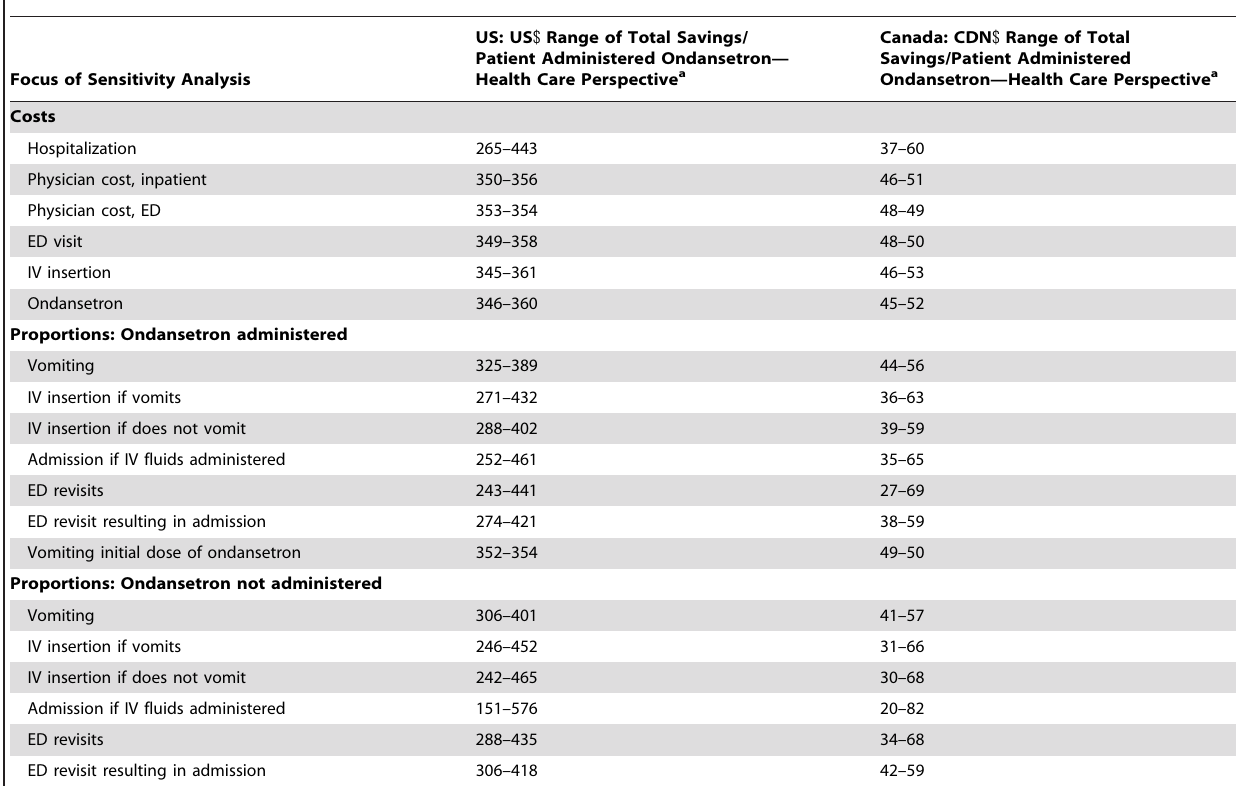
Table 4. Range of costs associated with maximal variation in individual parameters included in